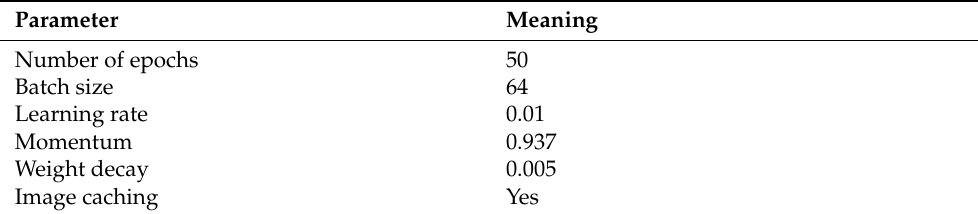
Table 2. Values of YOLOv5 first case hyperparameters during training.